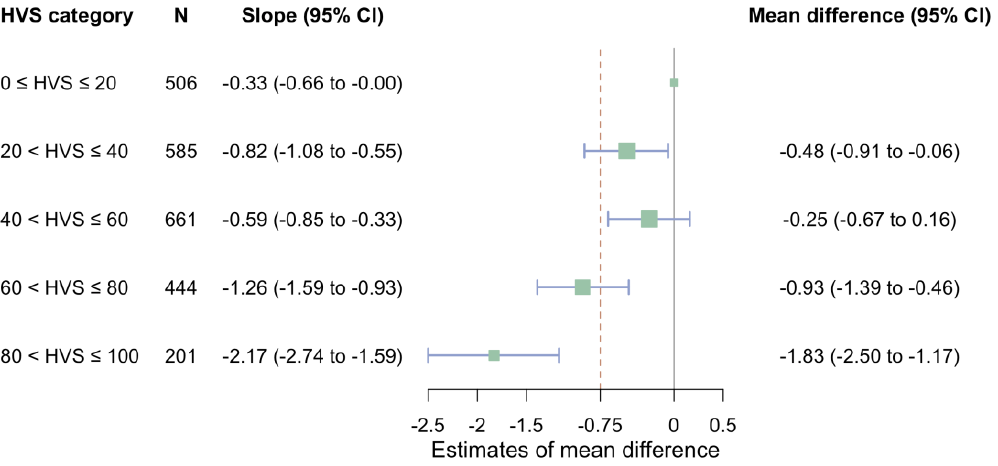
Figure 3. Difference across HVS categories in the mean eGFR slope starting from baseline to end of follow-up. Abbreviations: HVS, glycated haemoglobin A1c variability score; eGFR, estimated glomerular filtration rate; CI, confidence interval.